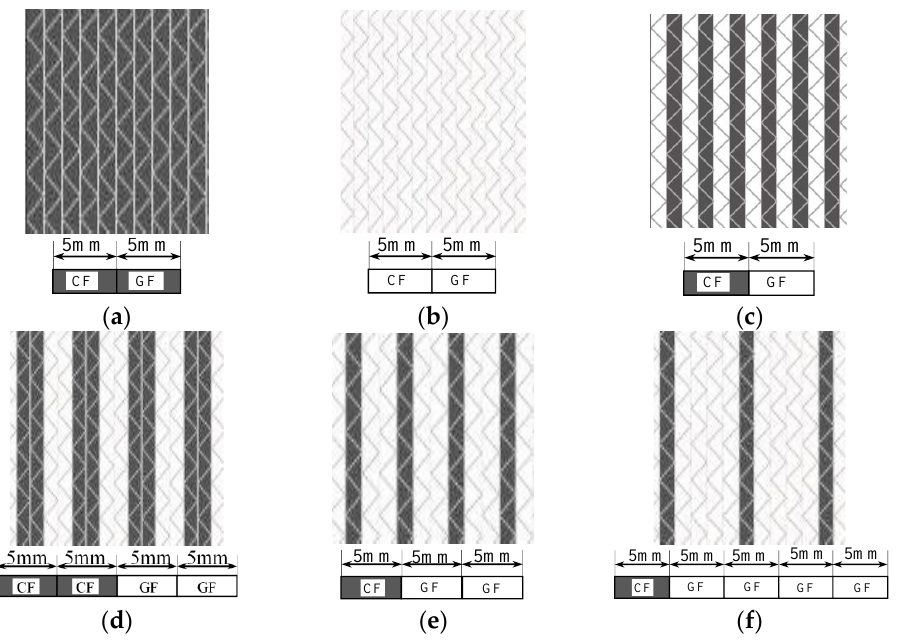
Figure 2. Schematic structures of six types of NCFs. ( a ) Carbon fabric; ( b ) glass fabric; ( c ) [C-G]; ( d ) [C-C-G-G]; ( e ) [C-G-G]; ( f ) [C-G-G-G-G].